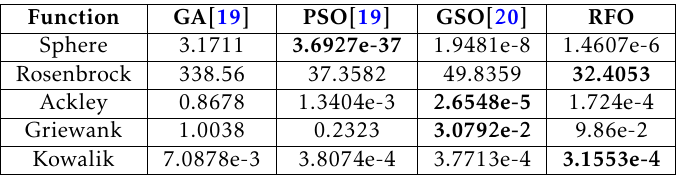
Table 4. Different Optimization Algorithms performance